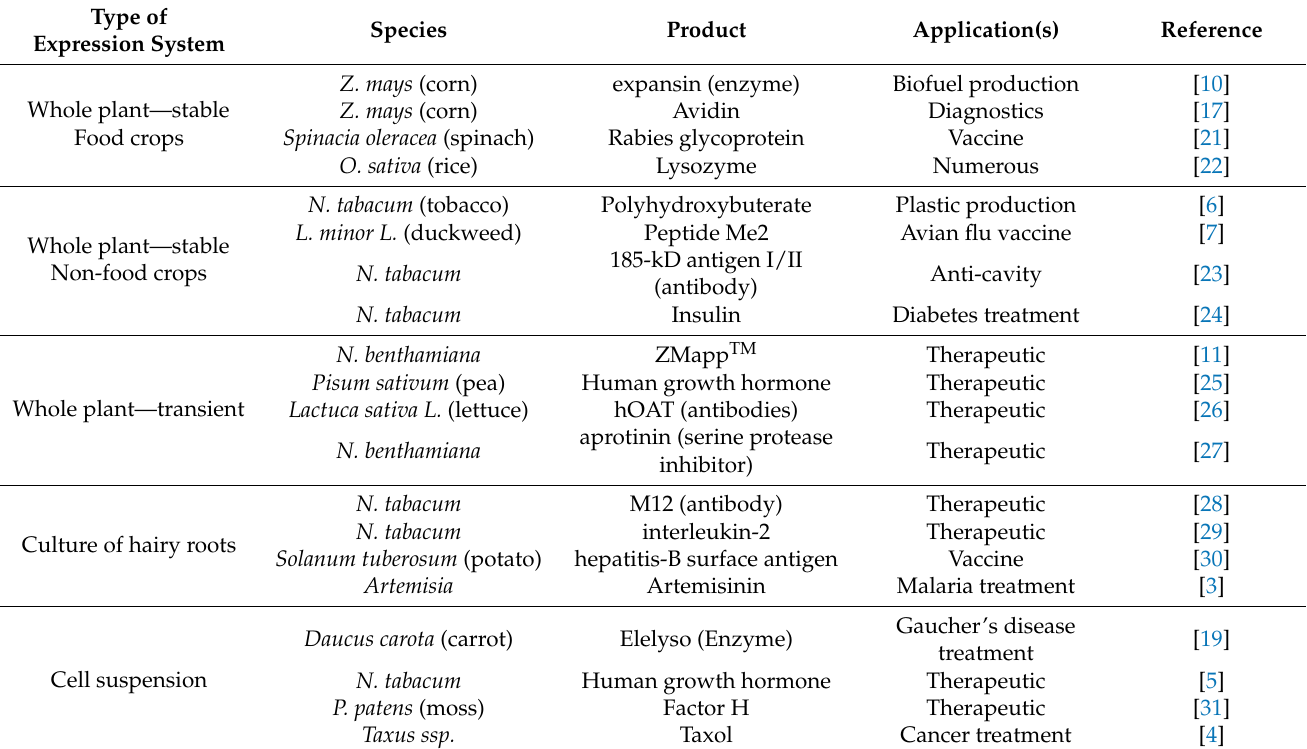
Table 1. Examples of molecular farming expression systems and